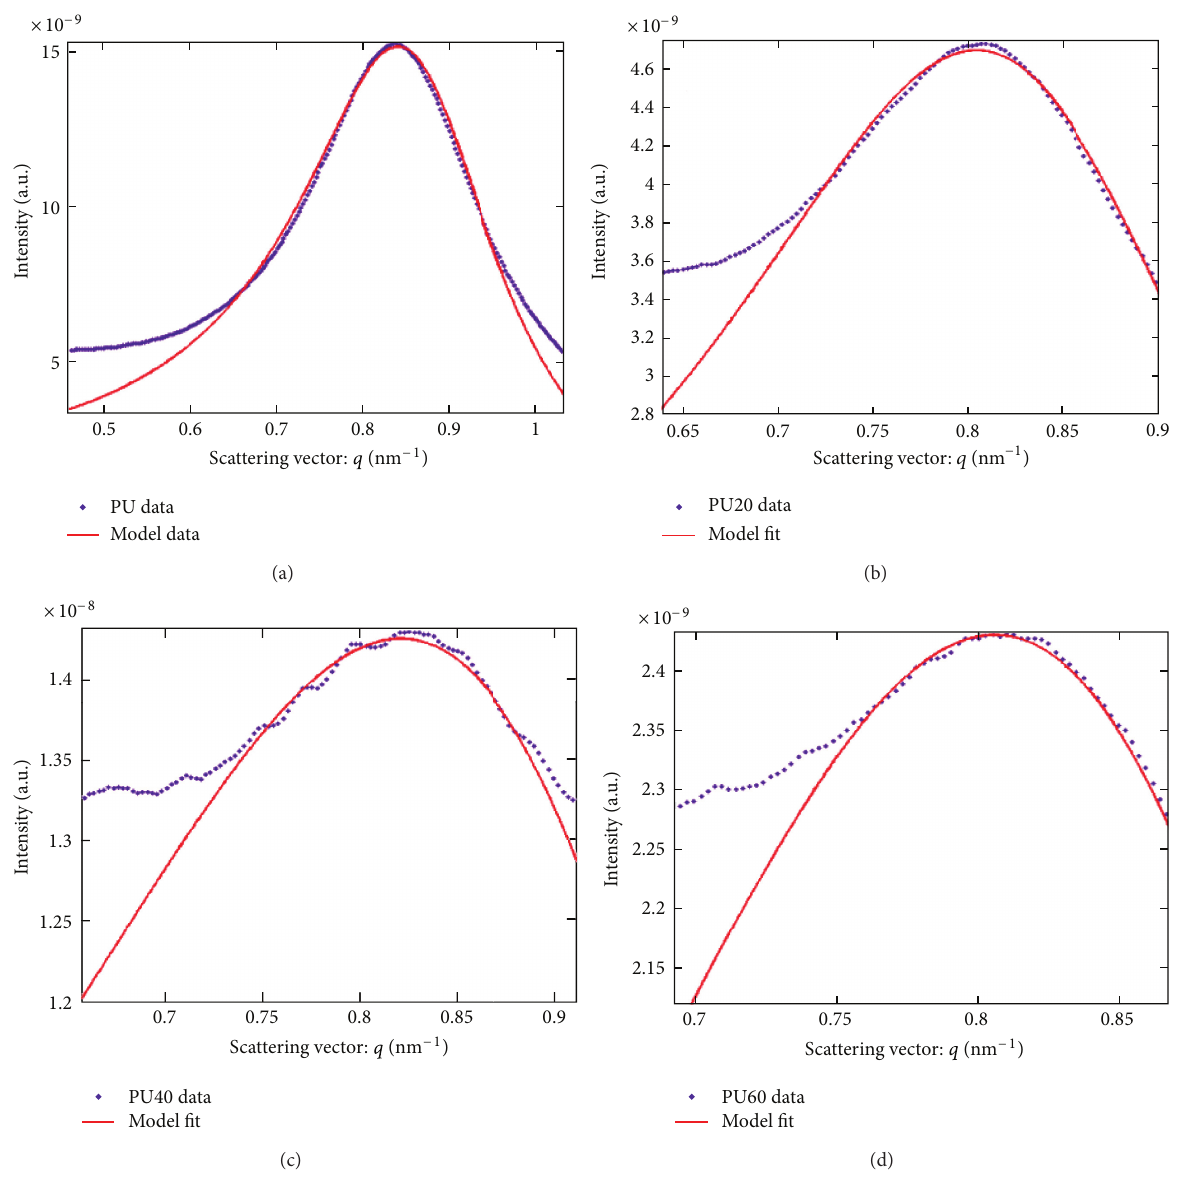
F 5: Curve �tting according to the Percus-�avick model for P� composites loaded with (a) �, (b) ��, (c) ��, and (d) 6�wt.